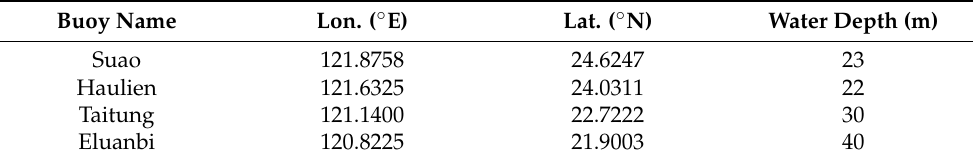
Table 1. Scenario simulations conducted in the present